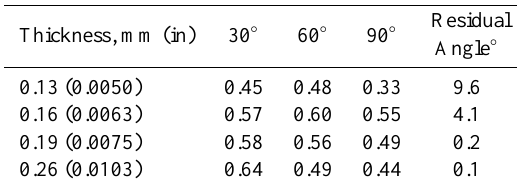
Table 4. Variation in Hinge Indexes and Residual Angles for di ff er- ent thicknesses of Tyvek ® .